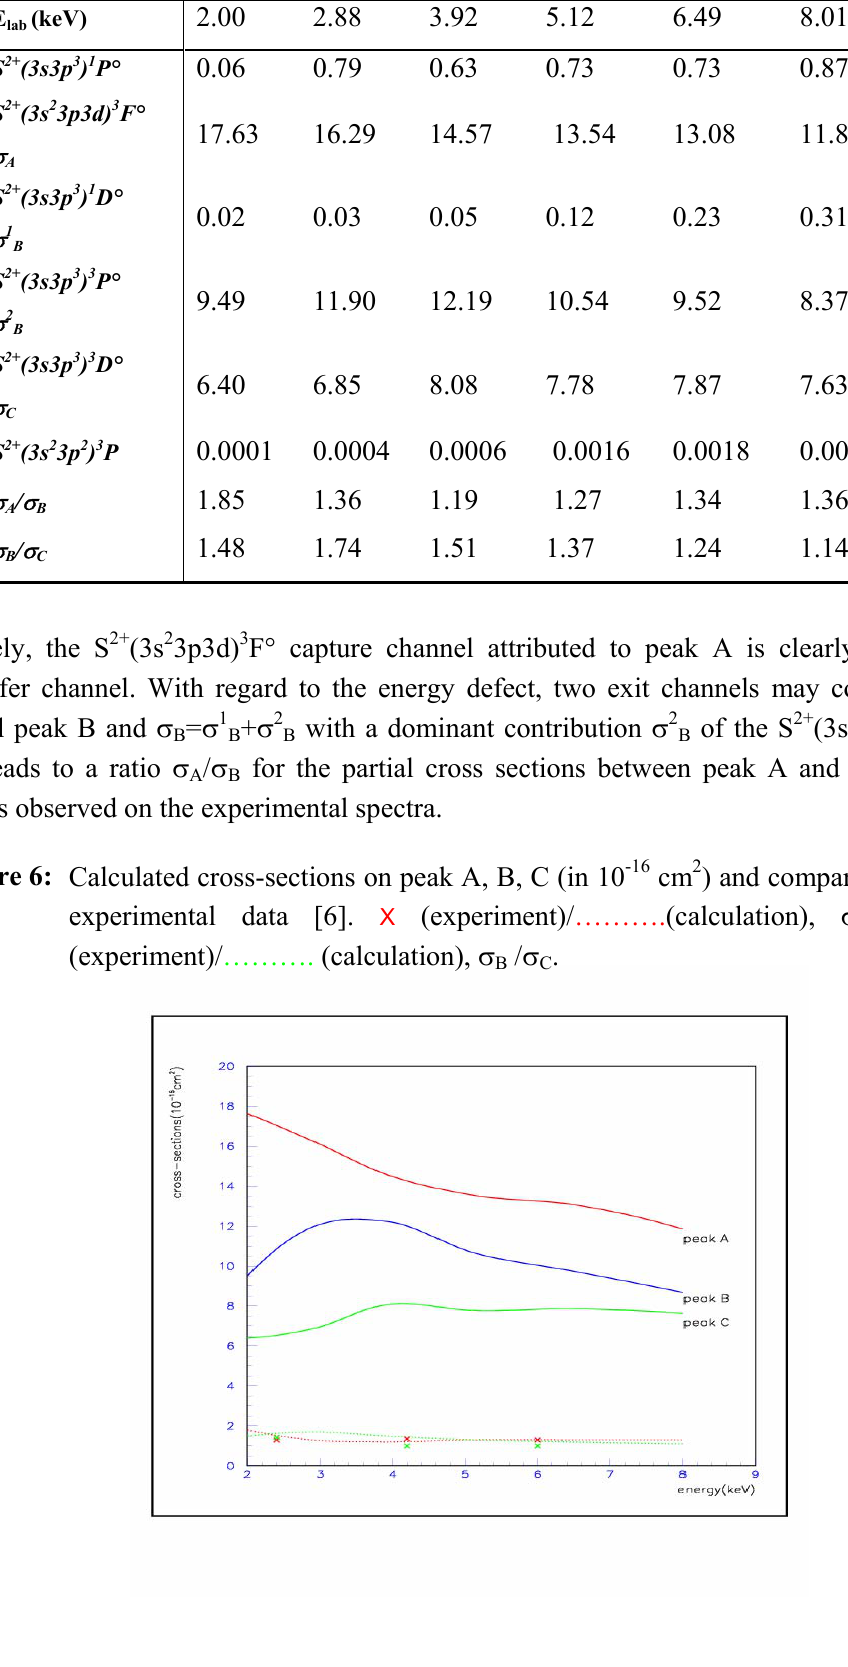
Table III: Partial cross sections on the exit channels in the S 3+ (3s 2 3p) 2 P° + H process (in 10 -16 cm 2 ).